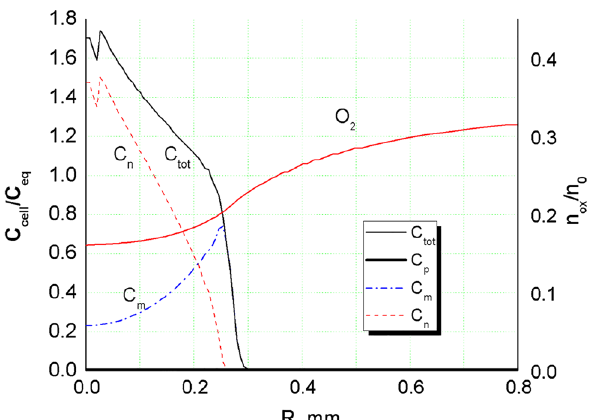
Figure9: Calculationscarriedoutforthesameconditions as on Figure 8, except for limited oxygen volume in the domain. ECM stiffness E ECM = 2.5 kPa, RBC for oxygen supply. Radial cell density distributions are presented for day 5: proliferative cells C p , hypoxic C m , necrotic C n , total cell density C tot ; and distribution of